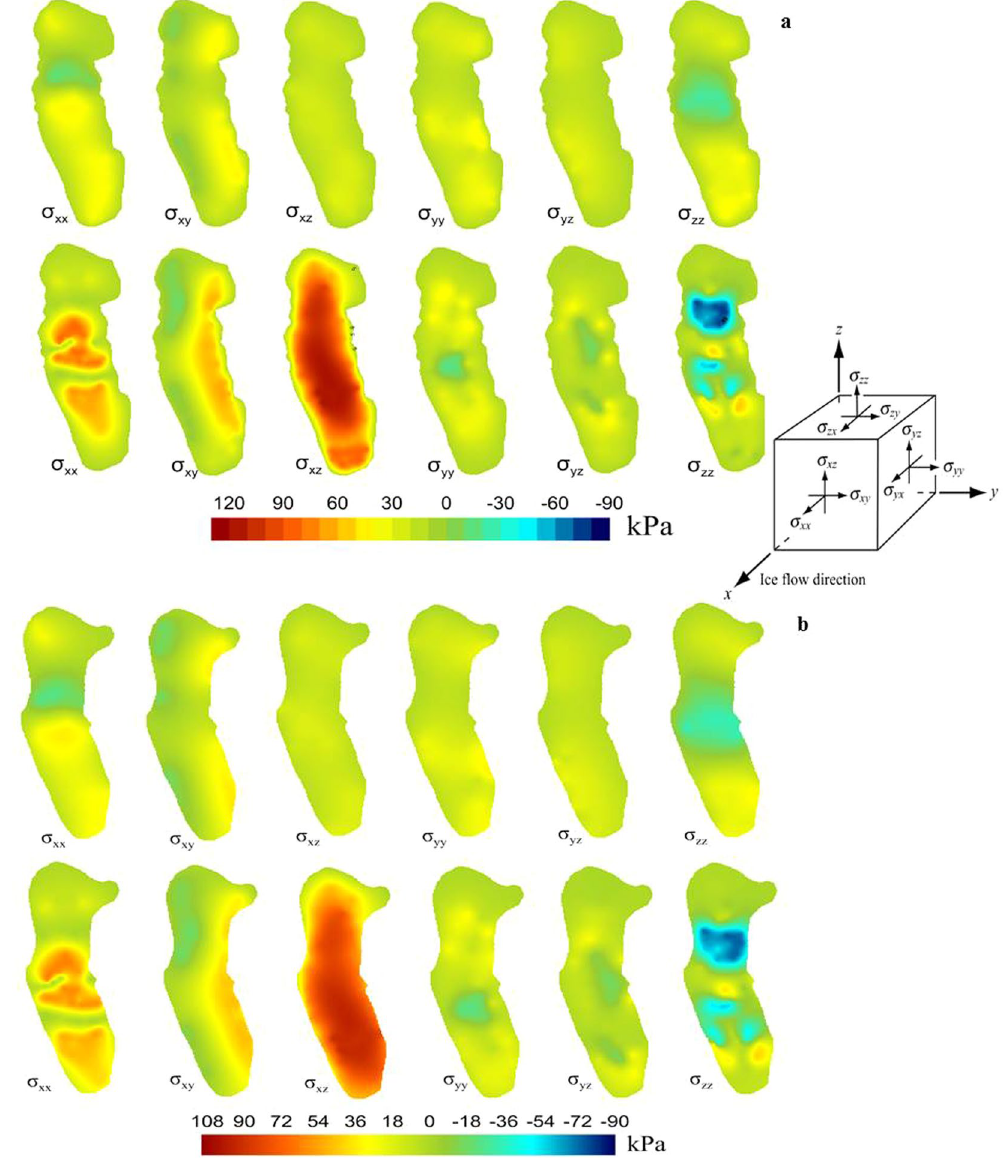
different directions in